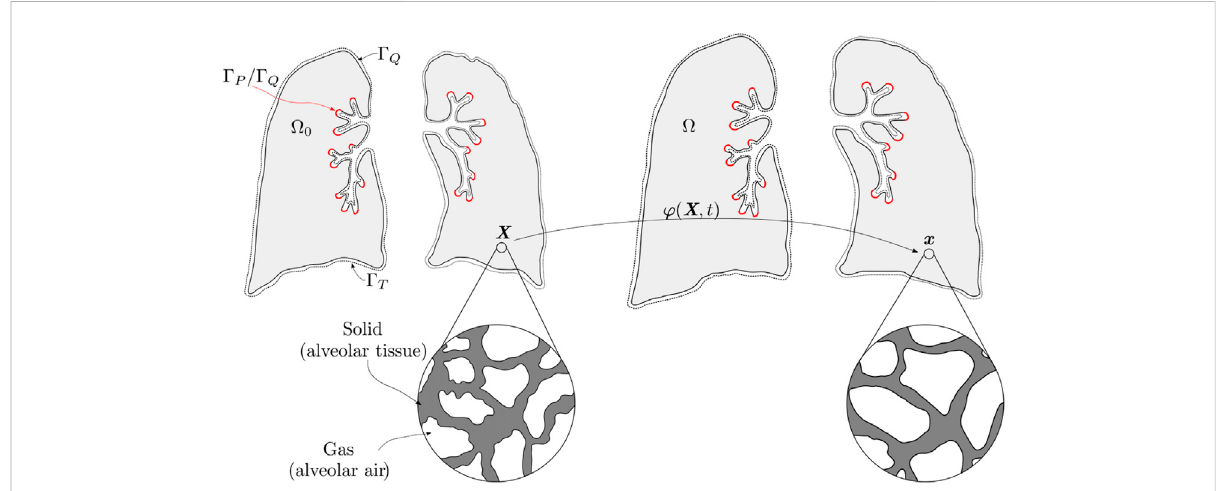
FIGURE 1 Material and spatial con fi guration of the lung continuum with porous composite idealization. The red color indicates the airway boundary, where it prescribes pressure or fl ow depending on the application; the complement of the surface is a null prescribed fl ow boundary. In addition, traction is prescribed on the whole